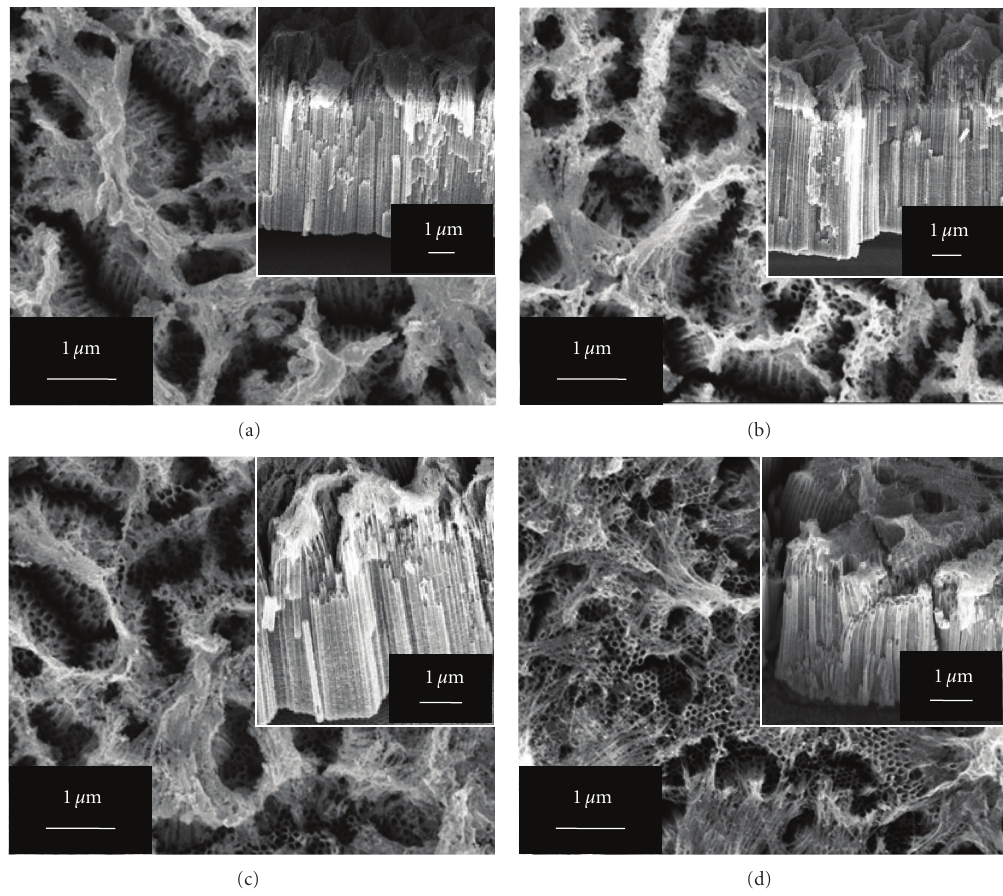
Figure 8: FESEM images of TiO 2 nanotubes obtained via chemical etching using 2% HF after anodization for (a) 10, (b) 15, (c) 20, and (d)